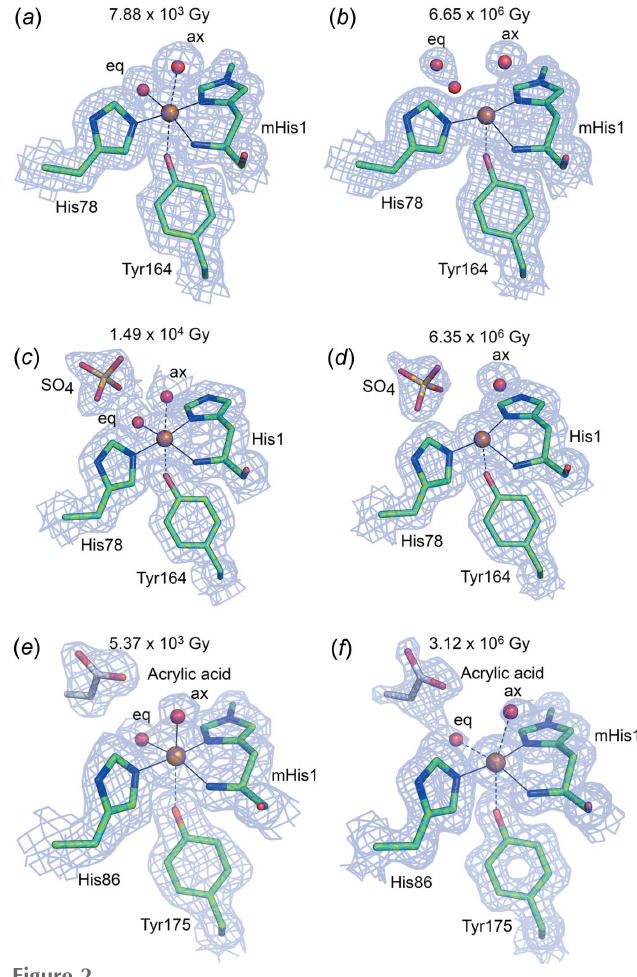
Figure 2 LPMO Cu sites in Ls AA9_A(f), Ls AA9_A( Ec ) and Ta AA9_A at the lowest and highest X-ray doses. Ls AA9_A(f) at ( a ) low and ( b ) high dose. Ls AA9_A ( Ec ) at ( c ) low and ( d ) high dose. Ta AA9_A at ( e ) low and ( f ) high dose. The distances between Cu (orange spheres) and the equatorial/ axial water molecules (red spheres) increase with increasing X-ray dose in the transition from Cu 2+ to Cu + . In some cases, the water molecules have been modelled in a double conformation ( b ) or left unmodelled due to a lack of electron density ( d ). Distances below 2.2/2.7 A˚ are shown as full lines (coordination distance), below 2.9/3.2 A˚ as dashed lines (close to coordination distance) and above 2.9/3.2 A˚ with no line (not coordi- nating) for the equatorial/axial ligands, respectively. 2 F o – F c electron density is shown at a 1.0 contour level as blue